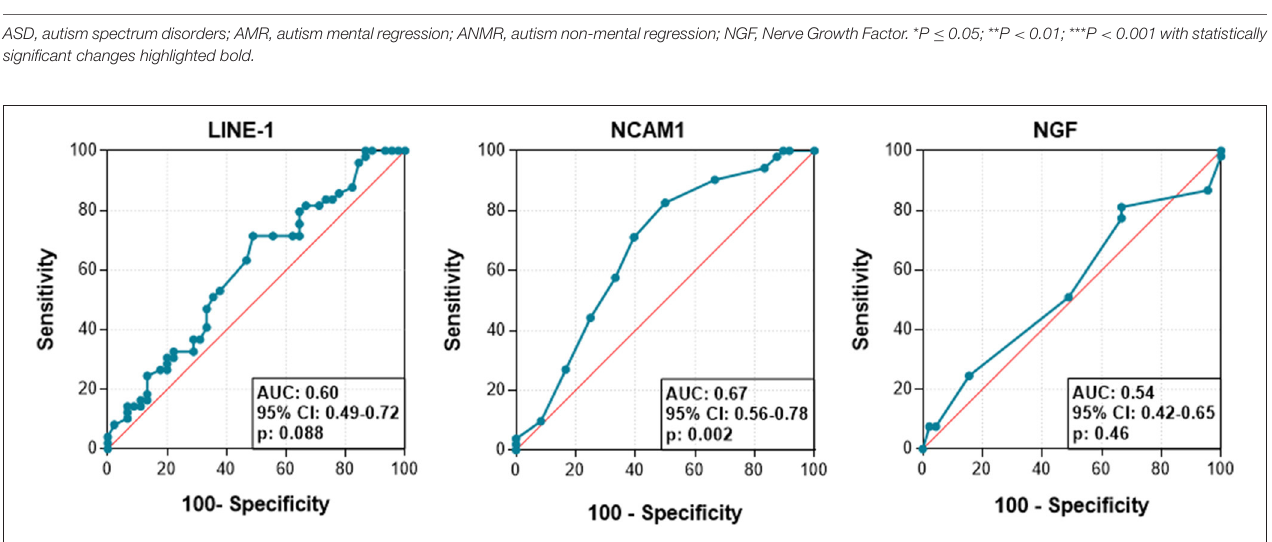
FIGURE 4 | Receiver operator characteristic curves (ROC) and area under the curve (AUC) values to differentiate ASD from healthy condition according to the methylation status of each